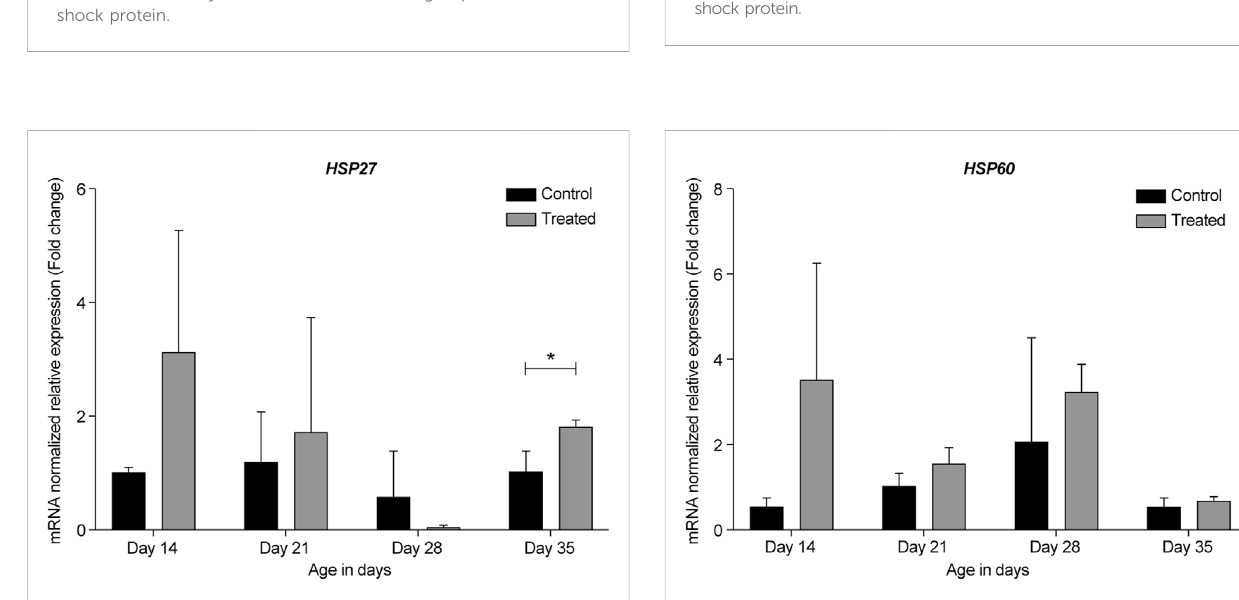
FIGURE 6 ΔΔ Ct of therelativenormalizedexpressionfor HSP27 inthecontrol (indoor) group and heat-treated (outdoor) chickens at 14-, 21-, 28-, and 35-days of age in the summer of 2021 ( n = 3 in each group, * p < 0.05). HSP, heat shock protein.